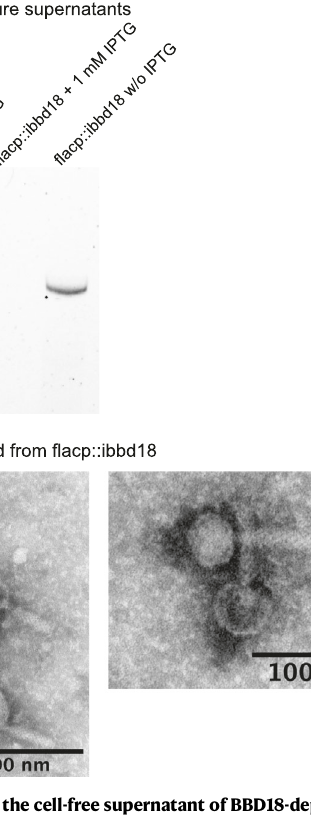
Fig. 6 | Presence of phage in the cell-free supernatant of BBD18-depleted cells. a A discrete band of DNA was detected in the DNase-treated supernatant of fl ac- p::ibbd18cellscultured inthe absenceofIPTG. b Supernatant of fl acp::ibbd18